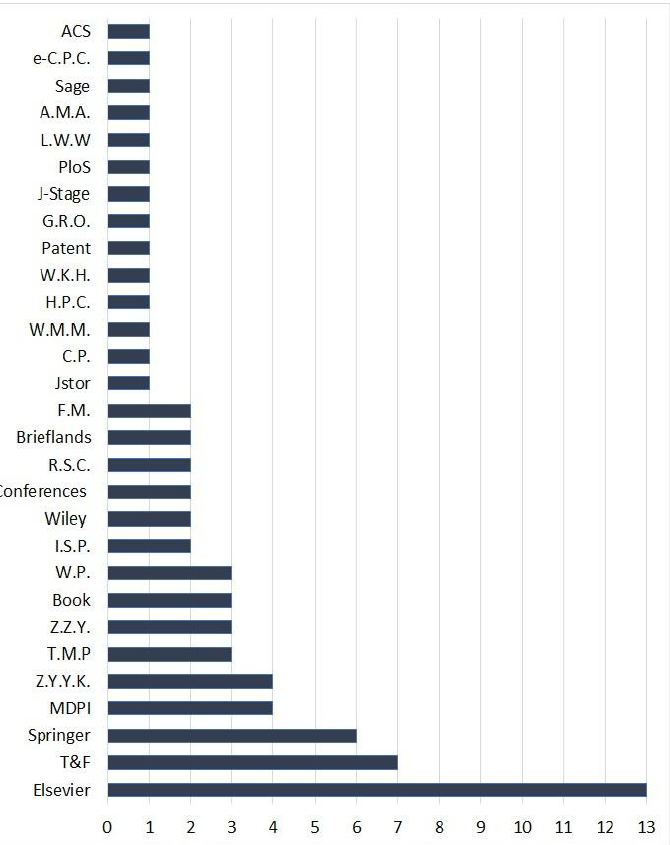
Figure 2. Sources of the cited references in this work and their numbers. T&F: Taylor and Francis